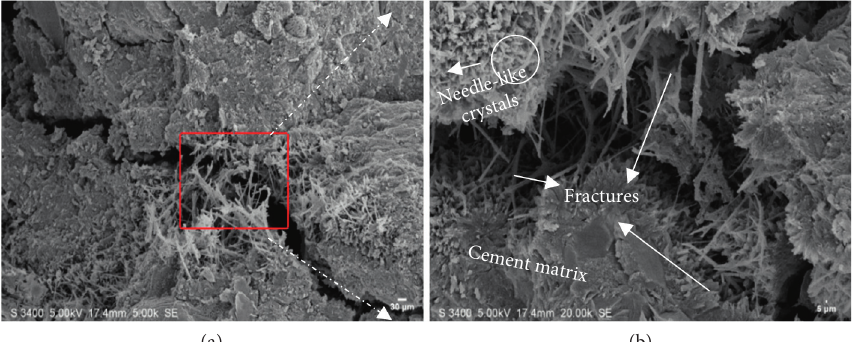
Figure 14: 150 freeze-thaw cycles. (a) SEM image of CRC. (b) Partially enlarged view of matrix